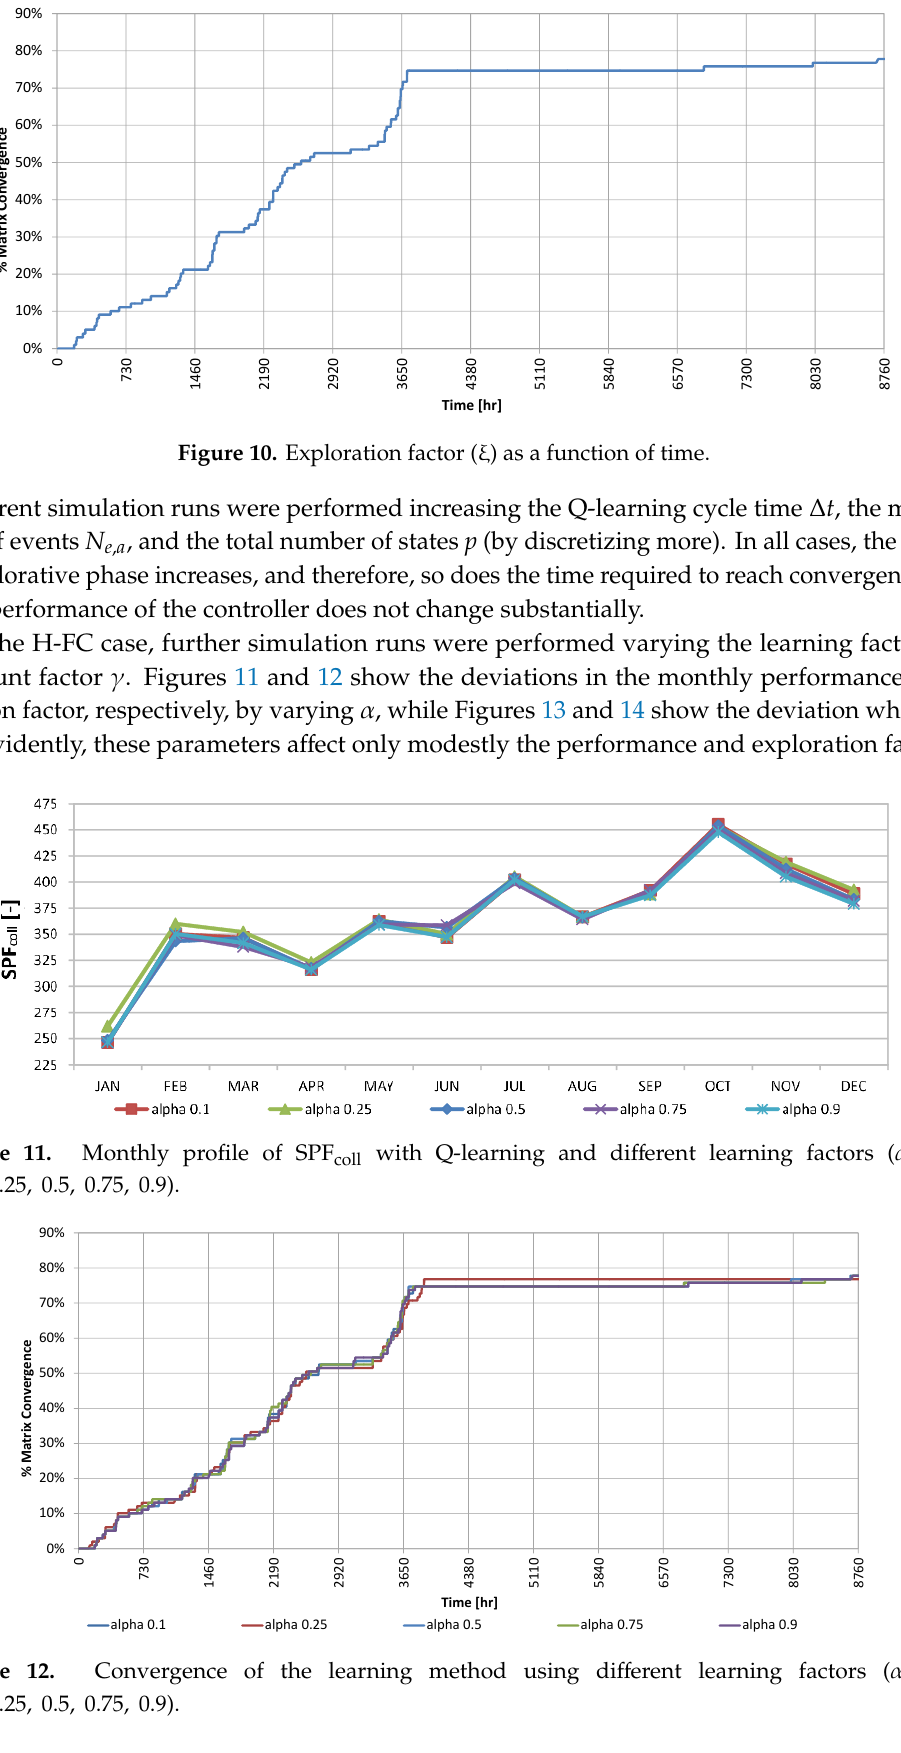
18 of 25 Figure 9. Monthly profile of the SPF coll with Q-learning coupled to the H-FC, comparing the monthly performance of the different year during the learning phase. This was confirmed by the exploration factor ( 𝜉 ) reported in Figure 10. It becomes apparent why the performance profile did not change significantly after the first year: the maximum of the exploration factor was reached within this time (in fact the first five months), meaning that what the